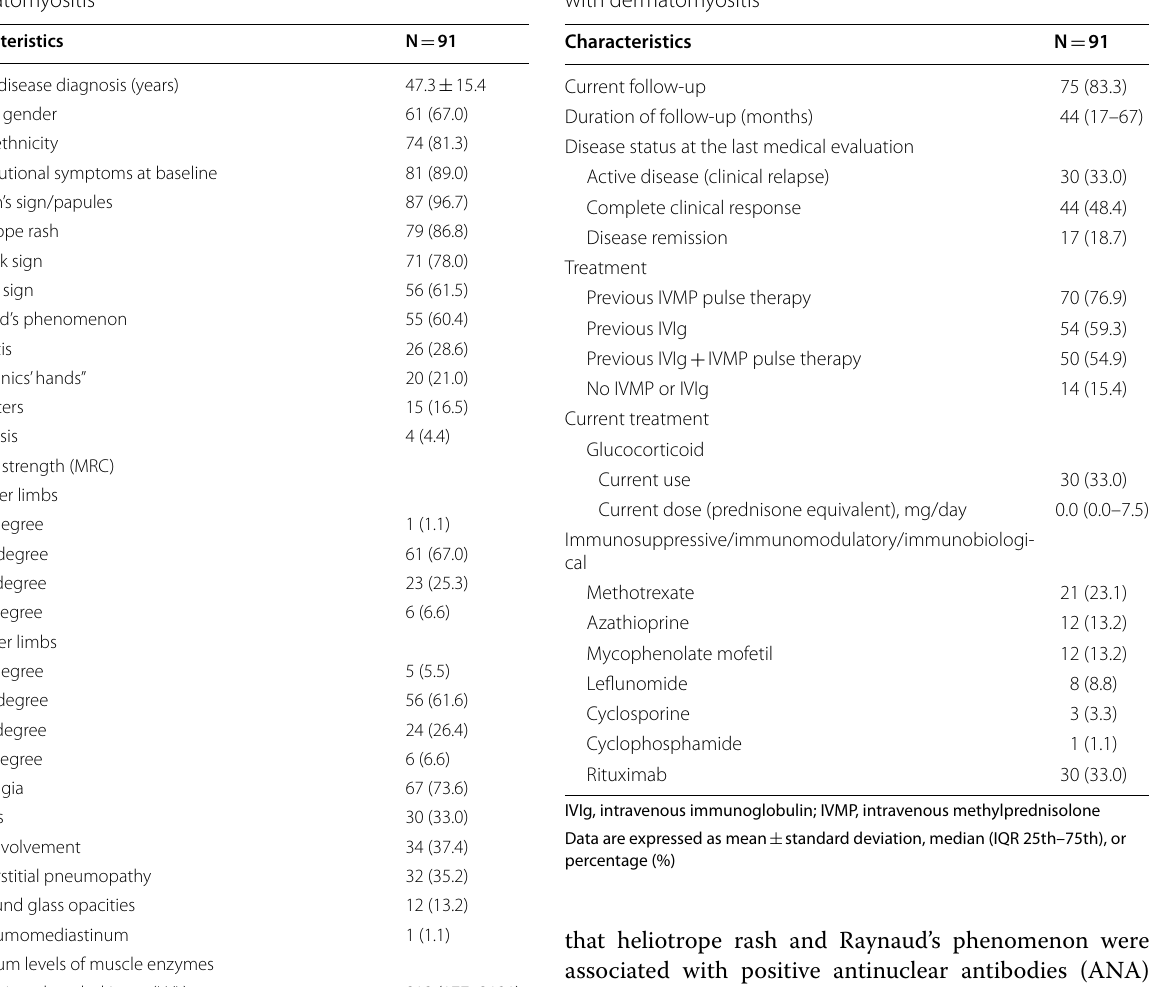
Table 1 General characteristics of 91 adult patients with defined dermatomyositis